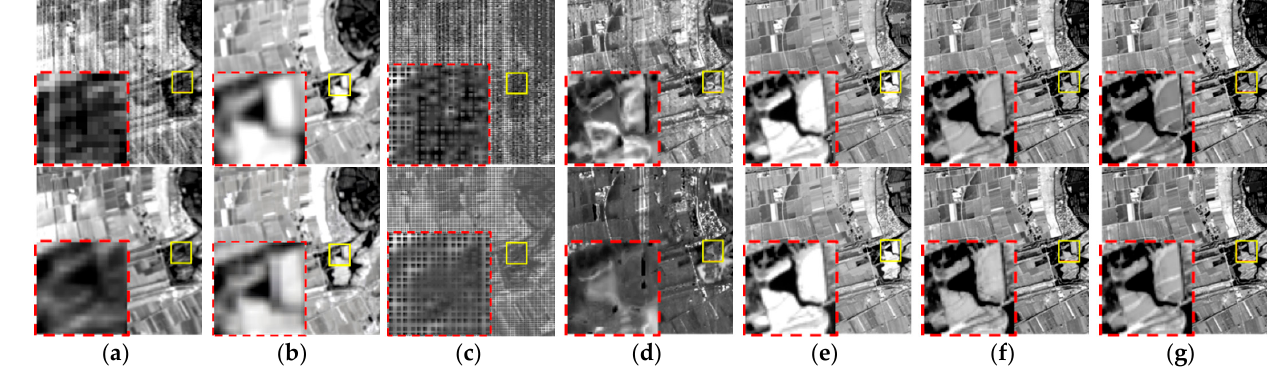
Figure 9. SRR results of ZY-1 02D HSI in band 166 before and after denoising. (( a ) column) Noising HSI (1st row) and denoised HSI (2nd row). ( b – g ) Columns are before (1st row) and after denoising (2nd row) SRR results of MIAE, FuVar, ECCV14, ICCV15, CNMF, and ours, respectively.